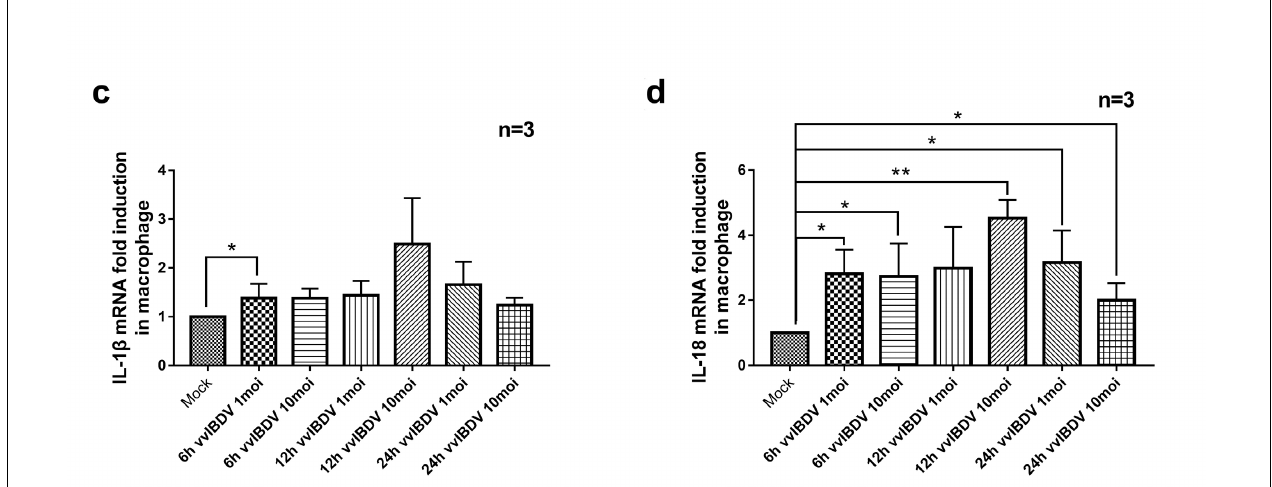
Frontiers in Microbiology |